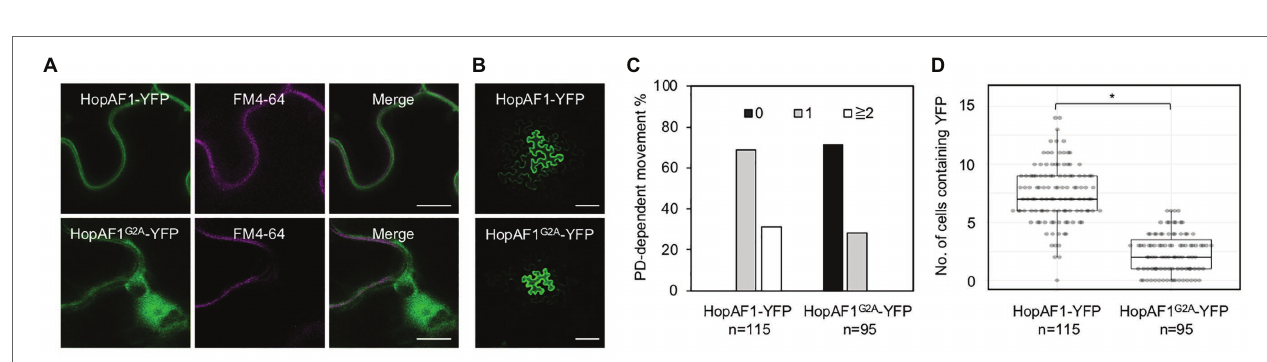
FIGURE 5 | The plasma membrane (PM) association of HopAF1 does not inhibit the PD-dependent movement. (A) Nicotiana benthamiana leaves transiently expressing HopAF1-YFP or HopAF1 G2A -YFP were stained with FM4–64 to label the PM. Confocal images show the PM localization of HopAF1-YFP and the nucleocytoplasmic localization of HopAF1 G2A -YFP. Scale bars = 10 μ m. (B) Confocal images show the PD-dependent movement of HopAF1-YFP or HopAF1 G2A -YFP determined by an Agrobacterium-mediated protein movement assay. Images were taken from the epidermis of N. benthamiana leaves. The transformed plant cell exhibits strong YFP signals. The movement of the fusion proteins is determined by the detection of YFP signals in cells surrounding the transformed cell. Scale bars = 100 μ m. (C) Quantitative data show the percentage of transformation events resulting in no diffusion (0), one cell layer diffusion (1), and two or more than two cell layers diffusion ( ≧ 2). The data shown here are pooled from at least three biological replicates. The number of transformation events analyzed is indicated ( n ). (D) Quantitative data present the numbers of surrounding plant cells to the transformed cells containing YFP signals. Mann-Whitney U Test was used to analyze the data. The p -value is <0.00001 (*). The number of transformation events analyzed is indicated ( n